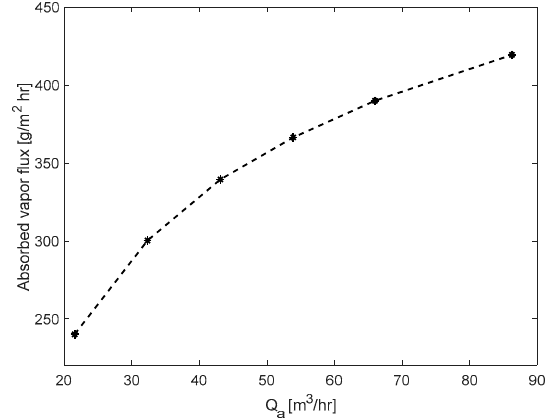
Figure 11. Effects of the airflow rate on the absorbed vapor flux by the 3F-CMC.